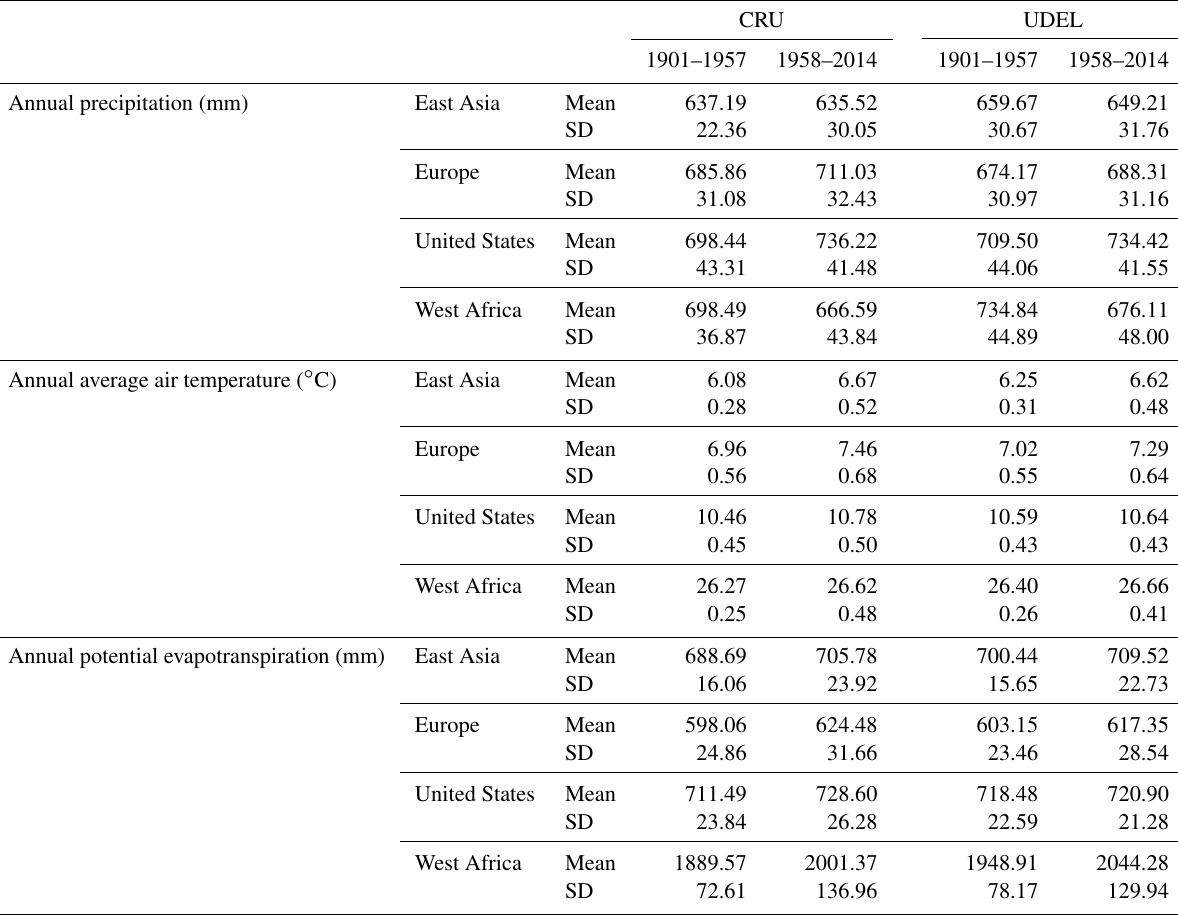
Table 3. Mean and standard deviation (SD) of precipitation and air temperature in each period and each region.